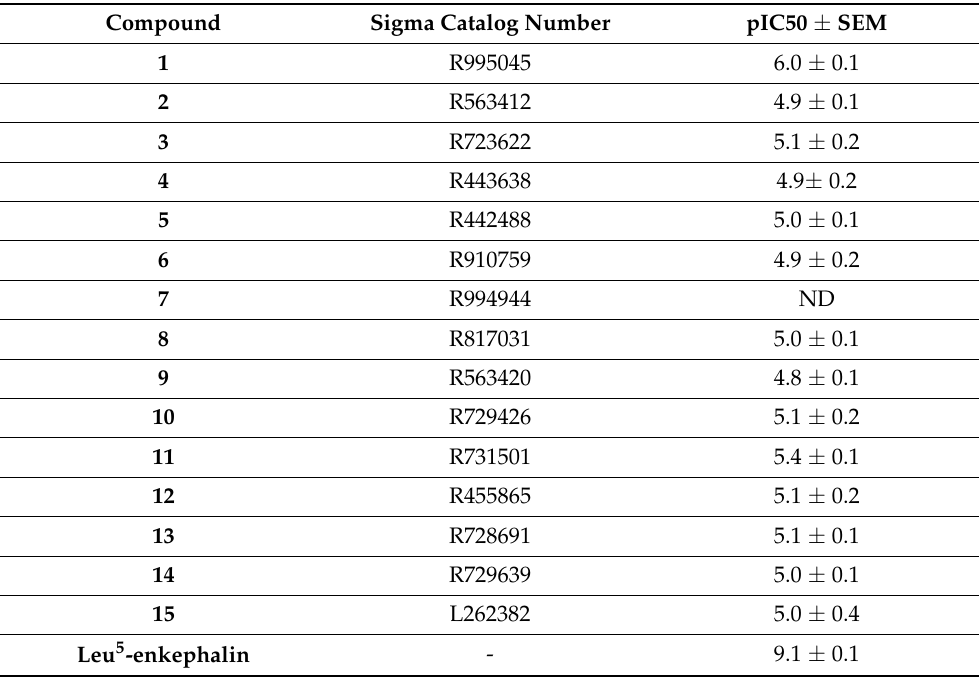
Table 2. Potency (pIC 50 ) and standard error (SEM) of analogs of compound 1 to inhibit cAMP signaling at δ OR. The sigma catalog number for each compound is provided. All compounds were tested in three or more independent